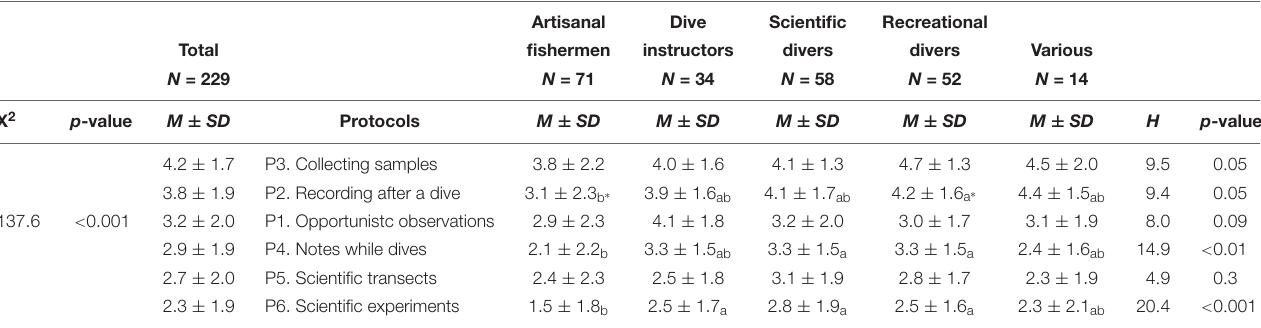
TABLE 5 | Preferences in different CS protocols for each diver type.